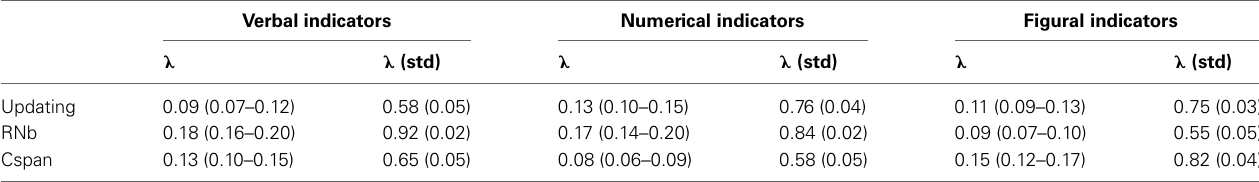
Table 1 | Estimates of Loadings for Model 1 (and Bootstrap Estimates of the 95% Confidence Intervals based on a Single Dataset) and Standardized Loadings (and Standard Errors Estimated on Multiple